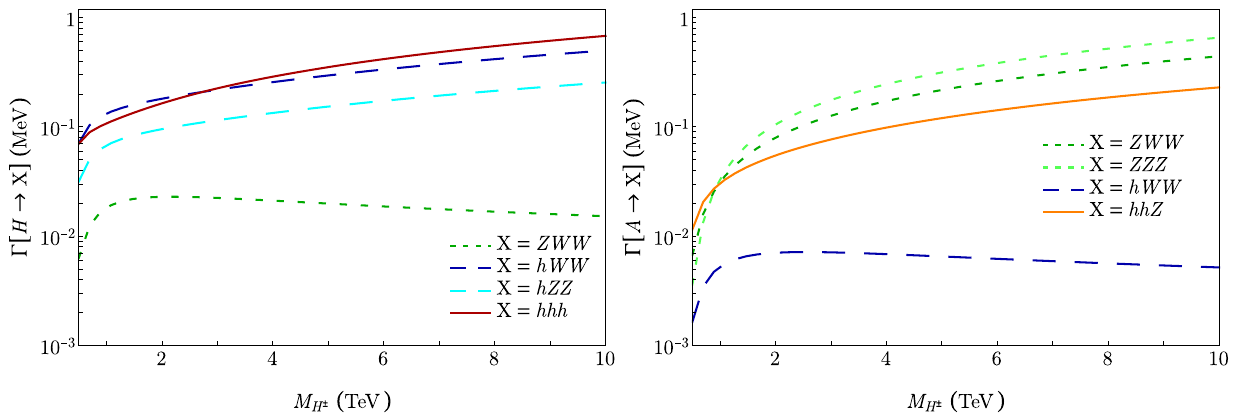
Fig. 2 Bosonic three-body decay widths as a function of the heavy Higgs scale in the MSSM at t β = 10: the non-trivial channels are plotted in the cases of a neutral CP -even (left) and CP -odd Higgs